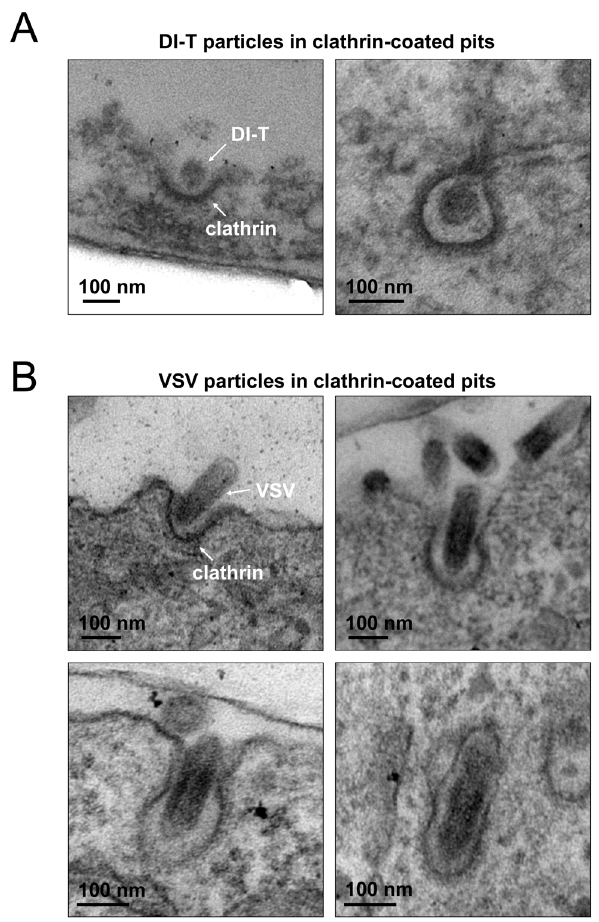
Figure 4. Electron microscopic images of DI-T and VSV particles in clathrin-coated pits. (A) Electron micrographs depicting DI-T particles at early (left) or late (right) stages of clathrin-dependent endocytosis. BSC1 cells were incubated with , 1000 particles per cell for 10 min. at 37 u C. Cells were then fixed, and samples were processed for ultra thin sectioning and viewed as described in the materials and methods. (B) Electron micrographs of VSV particles at sequential (left to right, top to bottom) stages of clathrin-dependent endocytosis. Vero cells were inoculated with VSV at an MOI of 5, and samples were prepared for analysis at 6 h